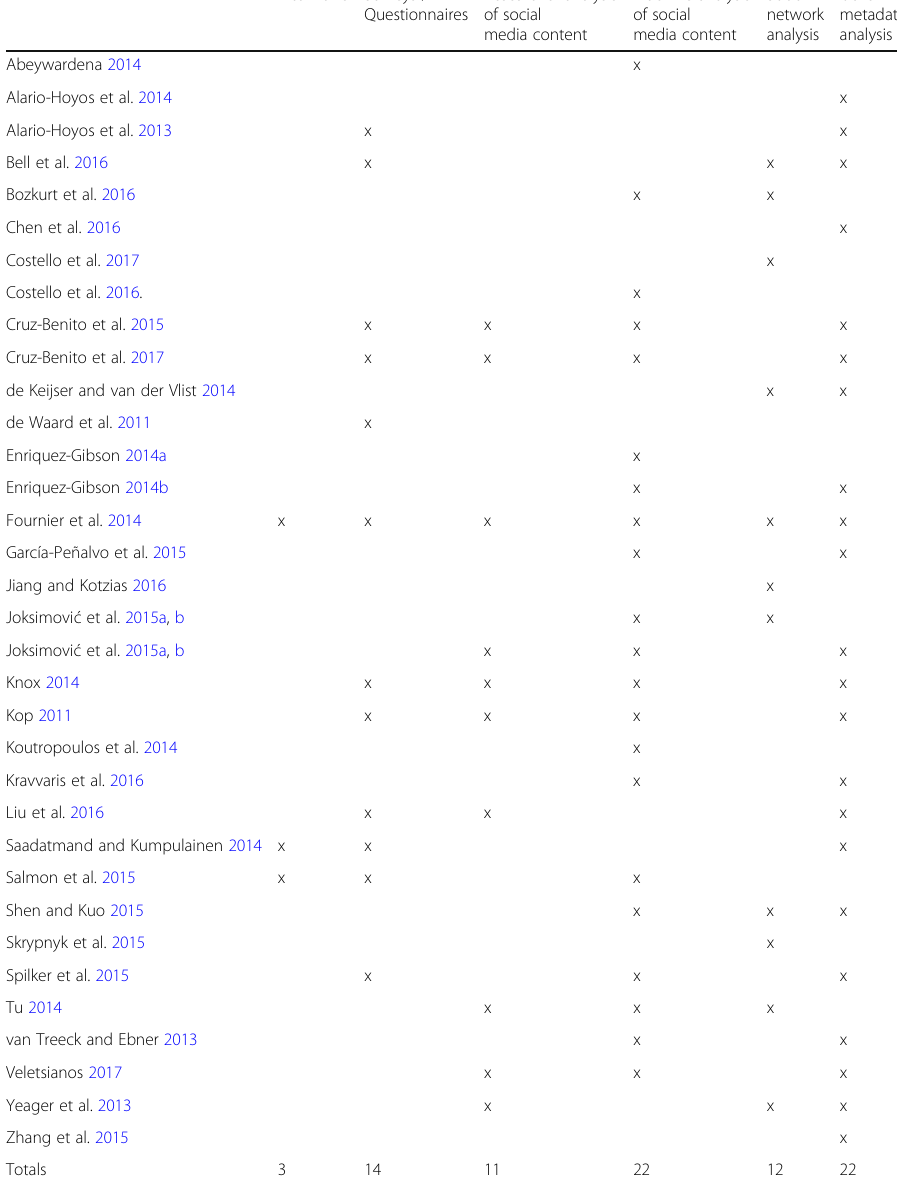
Table 1 Full Mapping of Research Methods